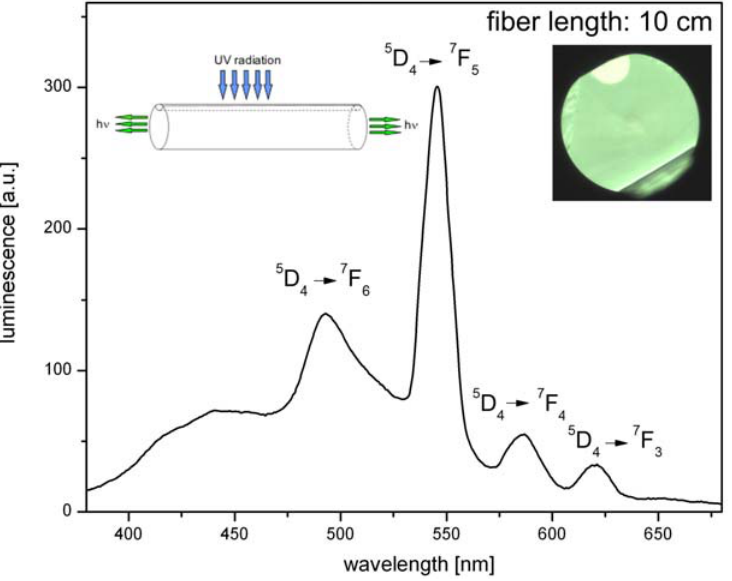
Figure 3. The emission spectrum of phosphate side-detecting optical fiber doped with 0.5 mol% Tb O . (the inset) Photograph of cross-section of fabricated fiber and scheme of 2 3 measurement